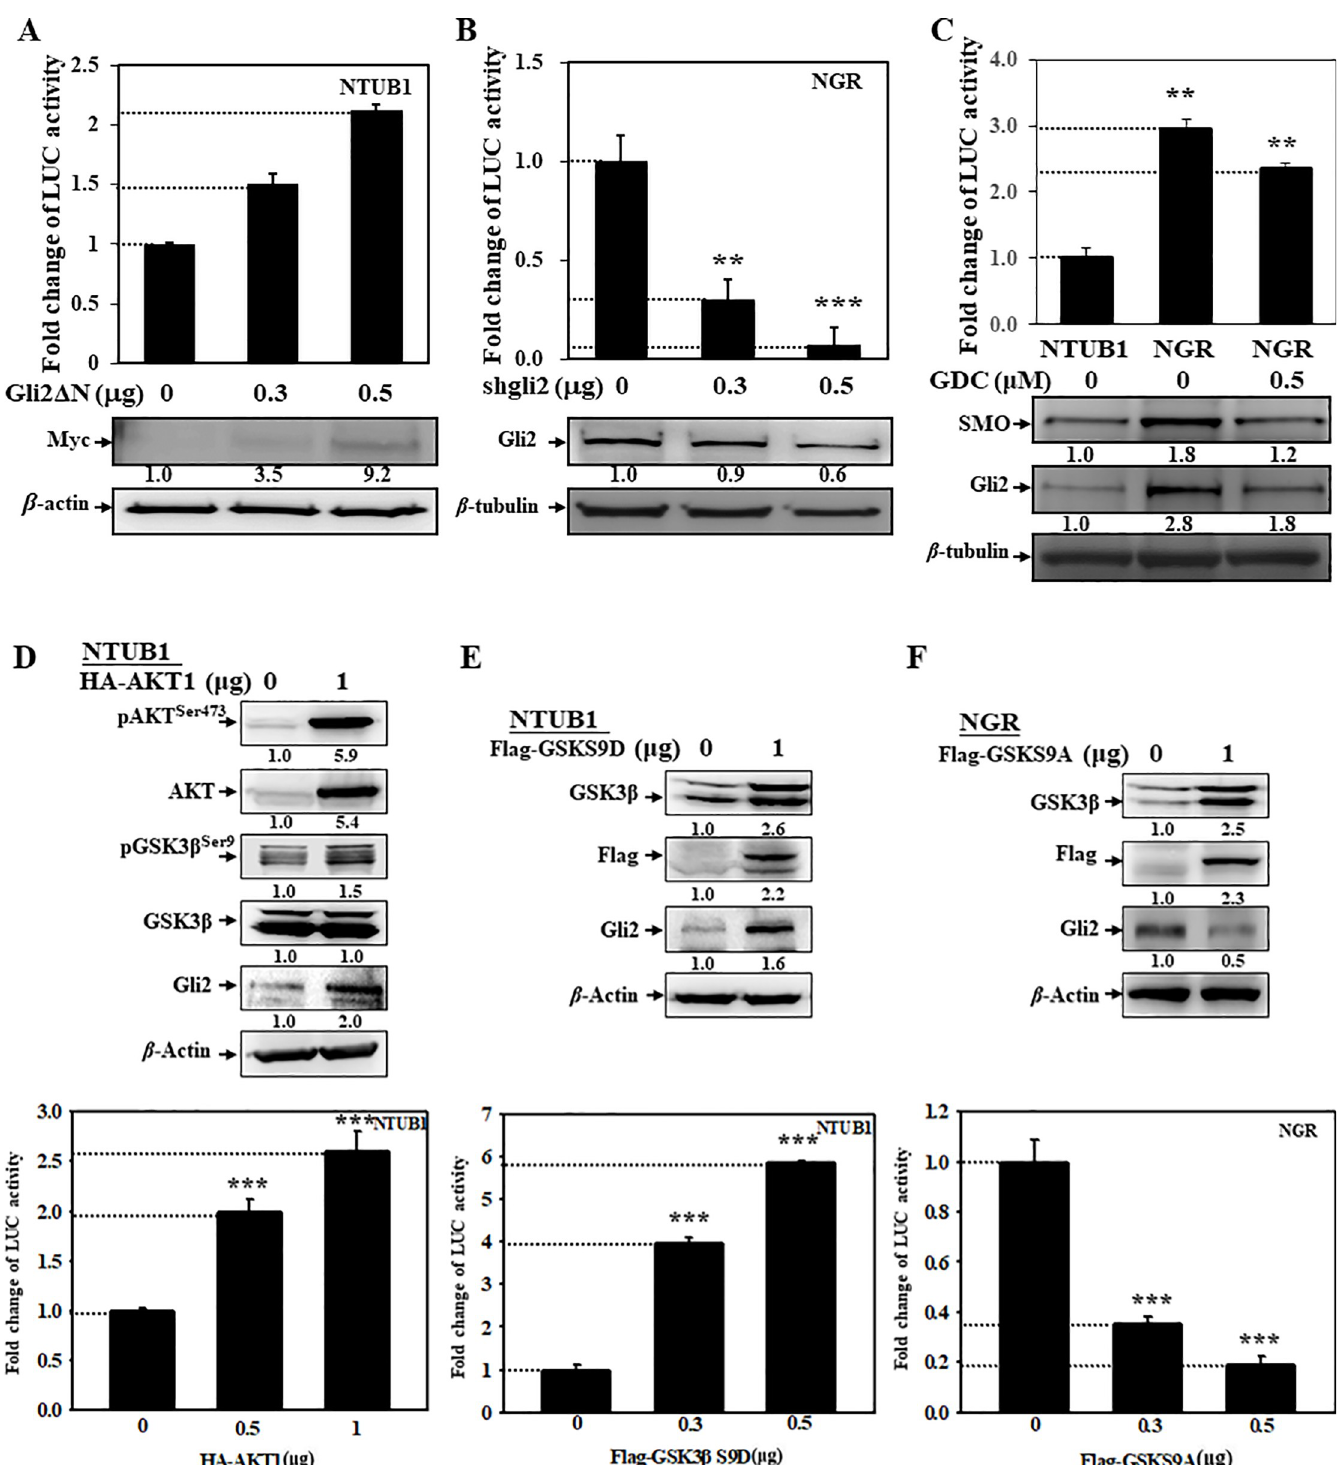
Fig 2. AKT/GSK3 β pathway regulated Gli2 activation in UC cells. Cells were co-transfected with reporters and (A) pCS2MT-Gli2 Δ N , (B) Gli2 specific shRNA plasmids, (D-F) pcAKT , Flag-GSK S9D (constitutively inactive GSK-3 β ), or Flag-GSK S9A (constitutively active GSK-3 β ) plasmids, respectively, and then harvested for the detection of their Gli2-luc activity and protein expression. (C) Cells were transfected with Gli-luc followed by treatment with SMO specific inhibitor, GDC0449, for 24 h. The Gli2-luc activity was measured as described in the “Materials and Methods” section.